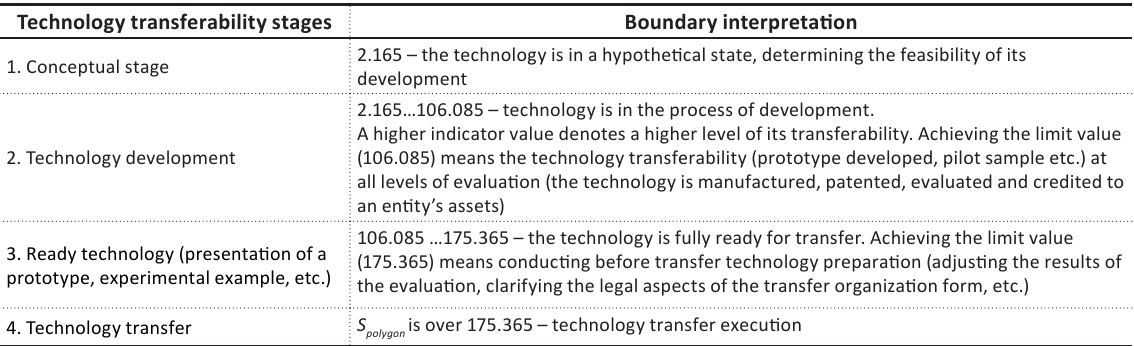
Table 2. Boundaries for integral indicators of the technology transferability level